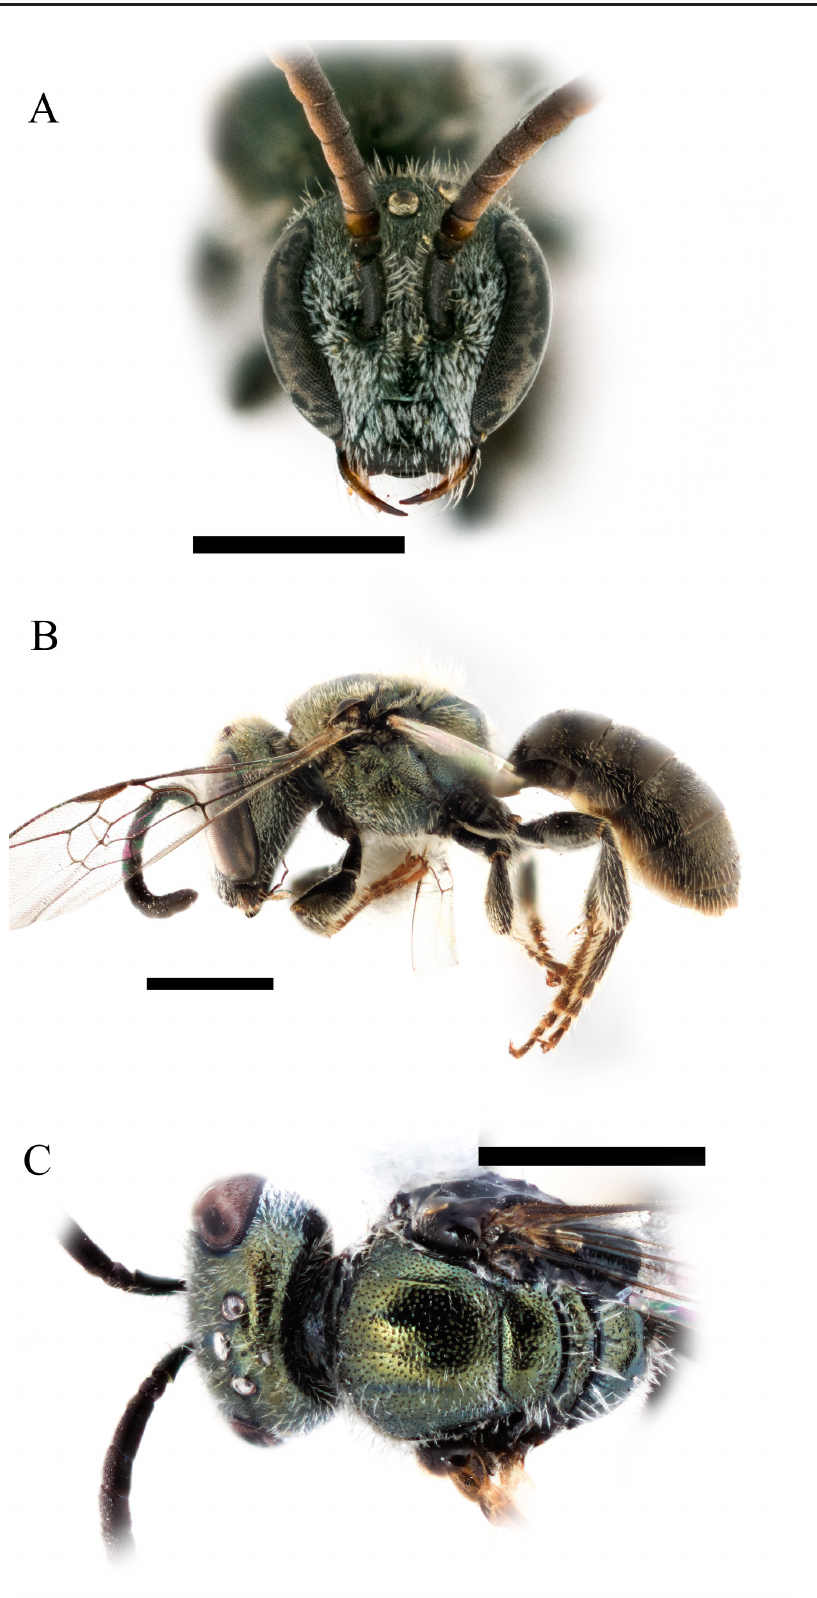
Fig. 6. Lasioglossum ( Dialictus ) kilpatrickae sp. nov. Paratypes, ♂♂. A . Face. B . Lateral habitus. C . Dorsum of mesosoma. Scale bars = 1